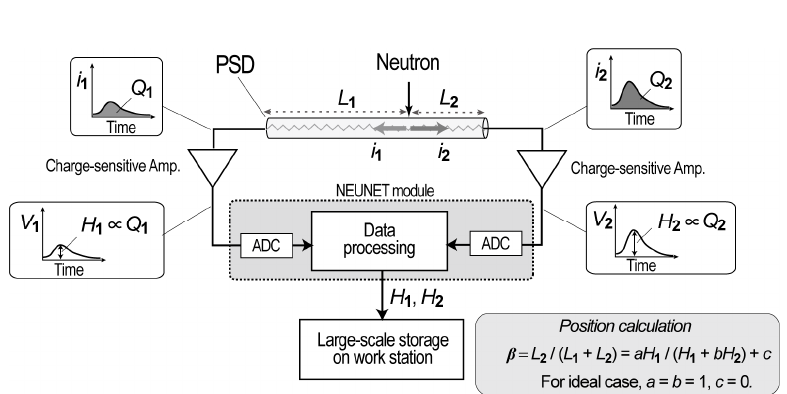
Figure 5. Schematic picture of charge-division method.